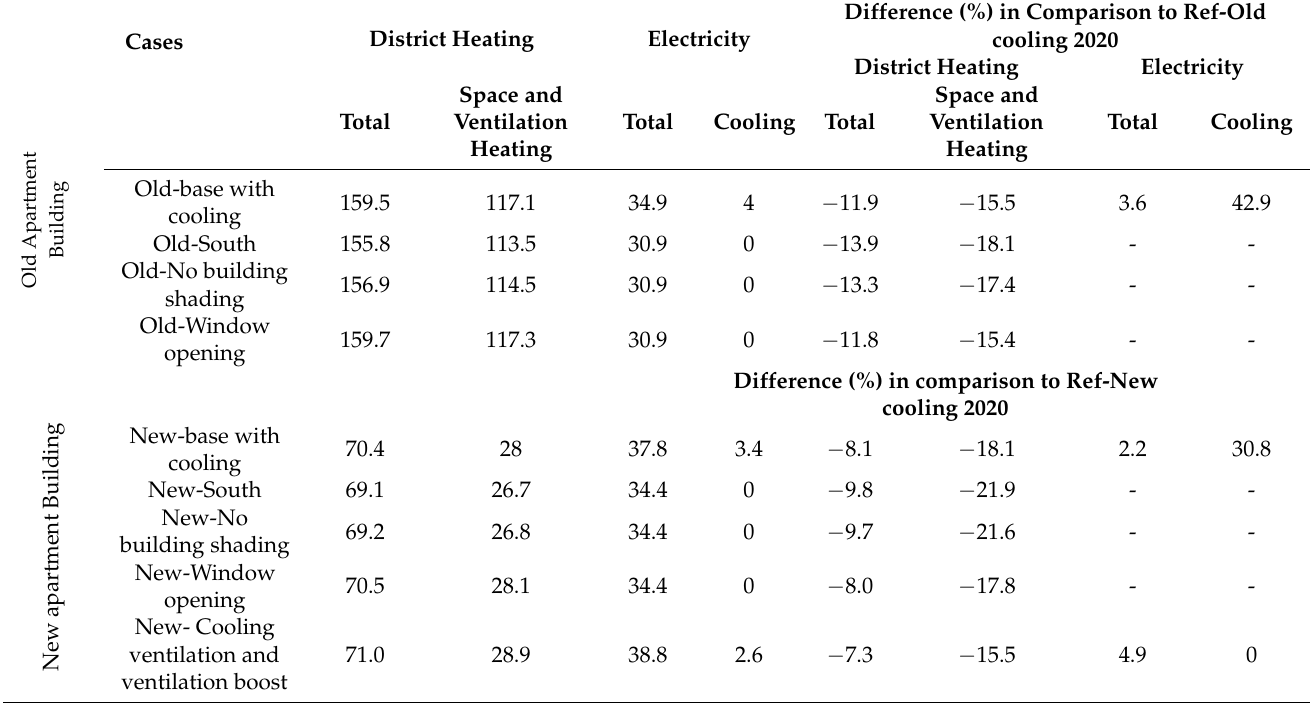
Table 6. Annual total purchased energy (kWh/m 2 a), in the projected future climate under the RCP4.5 scenario (TRY 2050). Cases